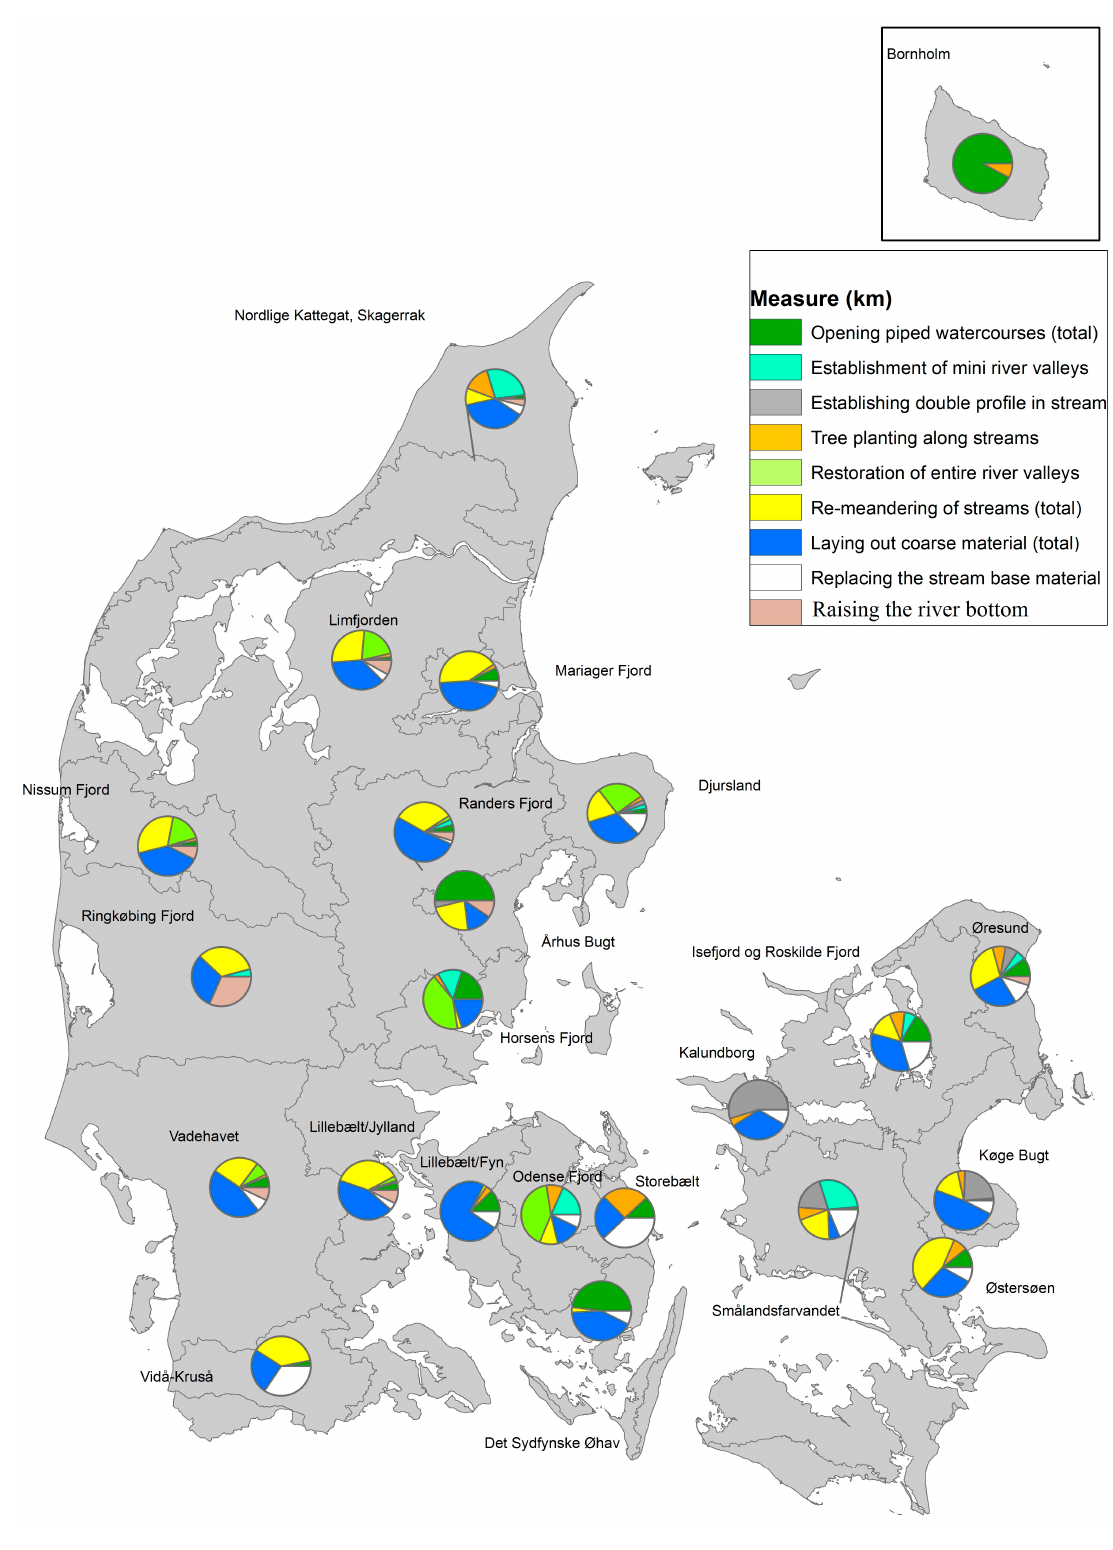
Figure 3. Geographical distribution in the RBDs of the selected measures, based on investment.